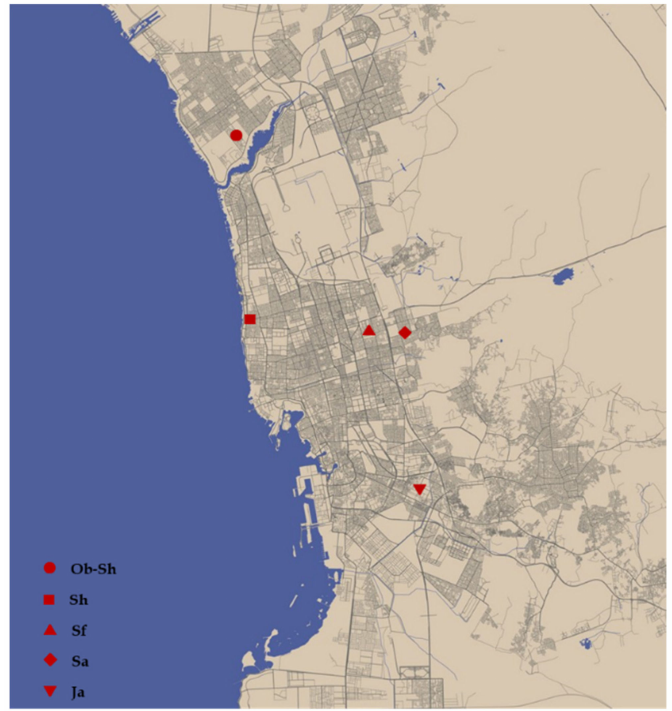
Figure 1. Sampling locations in Jeddah City, available at